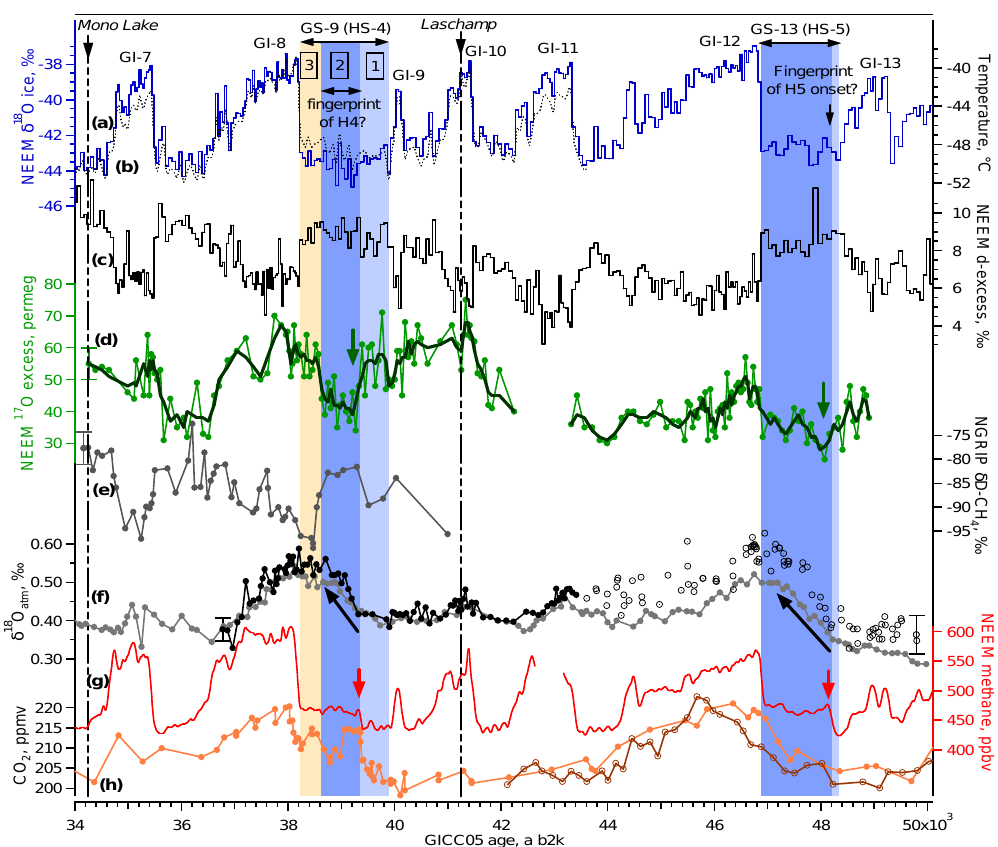
Figure 4. Greenland and Antarctic ice core records surrounding Heinrich events 4 and 5, synchronised to the GICC05 timescale (Ap- pendix A). Position of phase 1 (light blue area), phase 2 (blue area) and phase 3 (yellow area) as given in Table B1. Dashed-dotted vertical lines: position of the geomagnetic excursion events Mono Lake and Laschamp (Svensson et al., 2006, 2008). (a) Blue line: NEEM δ 18 O ice, ‰(precision: 0.07‰) (Guillevic et al., 2013). (b) Black dotted line: NEEM temperature reconstructed using δ 15 N data and firn modelling (Guillevic et al., 2013). (c) Black: NEEM deuterium excess, ‰( ± 0.7‰), this study, measured at LSCE (France). (d) Green dots: NEEM 17 O-excess, per meg ( ± 5 per meg), this study, measured at LSCE. Each dot corresponds to the average over 55cm of ice. Green line: three- point running average. (e) Dark grey: NGRIP δ D-CH 4 , ‰( ± 3.4‰) (Bock et al., 2010). (f) Black dots: NEEM δ 18 O atm , ‰( ± 0.03‰), this study, measured at LSCE. Black circles: NGRIP δ 18 O atm (Huber et al., 2006). Grey dots: Siple Dome δ 18 O atm (Severinghaus et al., 2009). (g) Red: NEEM methane mixing ratio, ppbv ( ± 5ppbv), record measured by the CIC instrument (Chappellaz et al., 2013). (h) CO 2 mixing ratio, ppmv. Orange dots: Byrd ice core, Antarctica (Ahn et al., 2012). Brown open circles: TALDICE ice core, Talos Dome, Antarctica (Bereiter et al.,